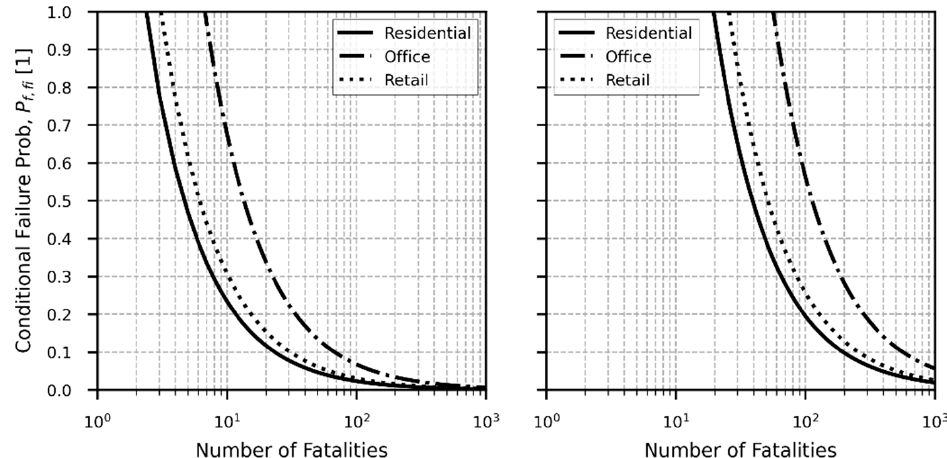
Figure 6. Conditional acceptable failure probability in the event of a structurally significant fire in function of the number of fatalities based on the principle of relative (marginal) lifesaving costs ( left ) without sprinklers, ( right ) with sprinklers.